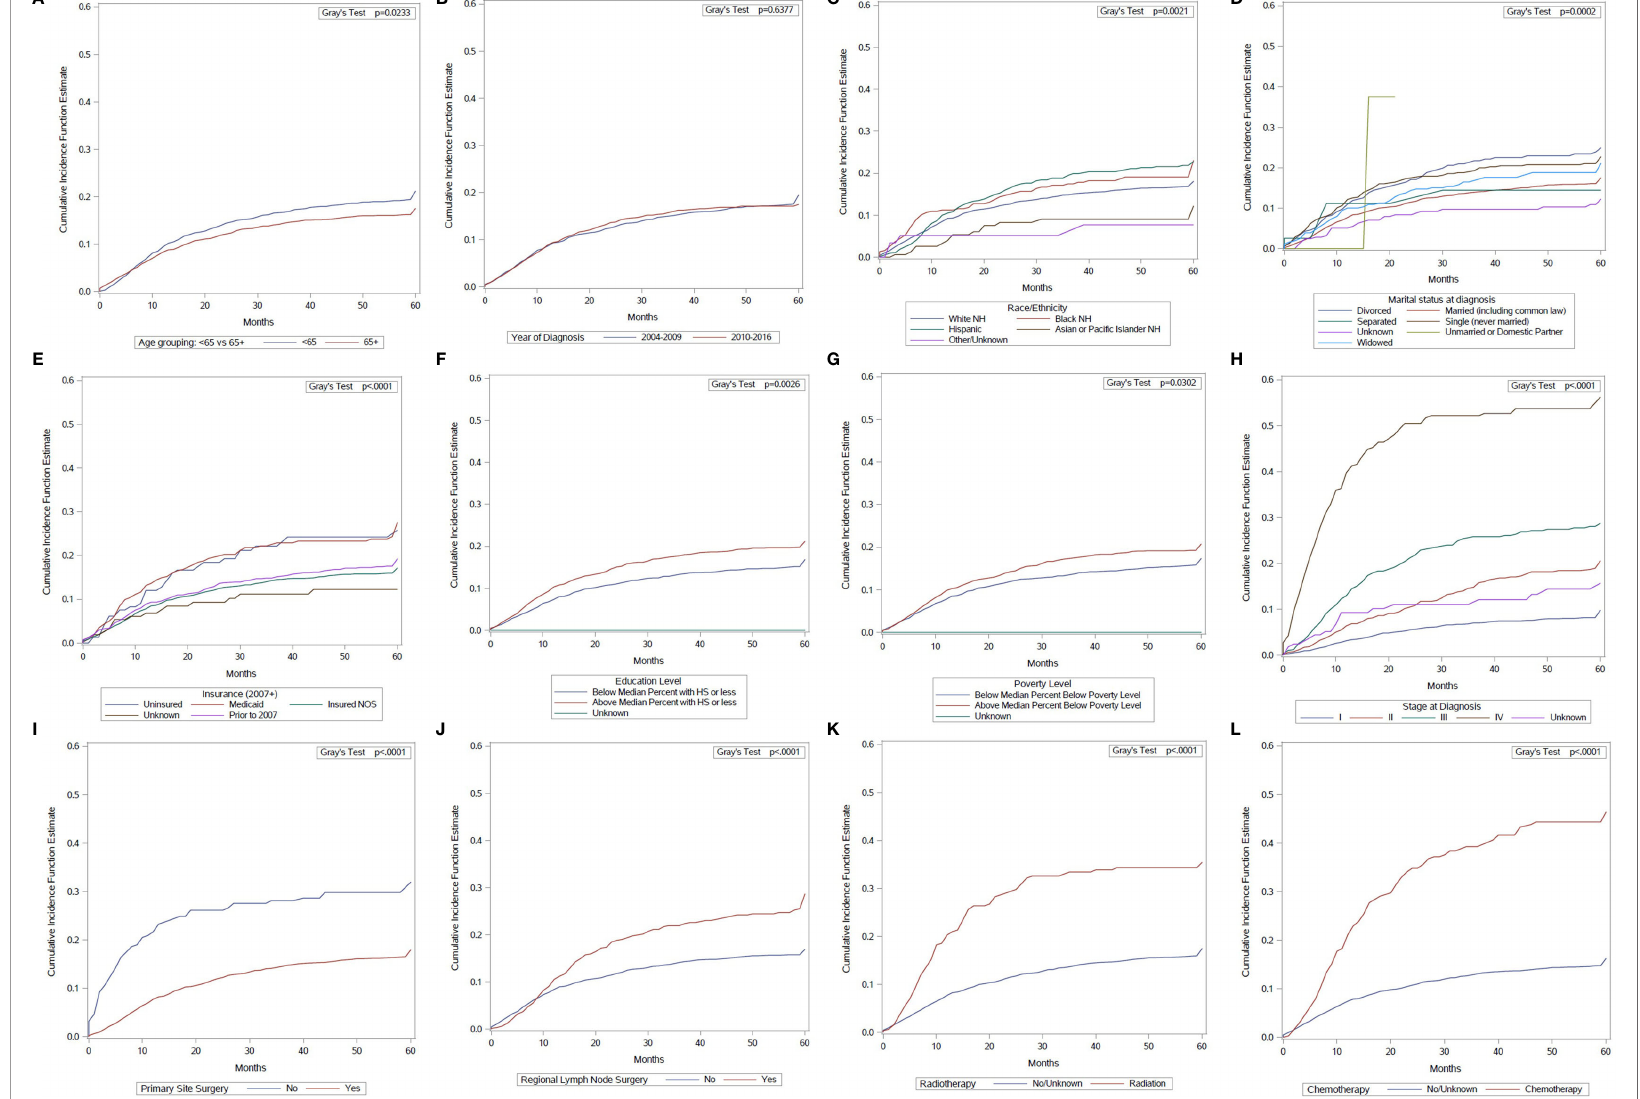
FIGURE 2 | Cumulative incidence function curves of penile cancer mortality according to: (A) age at diagnosis; (B) year of diagnosis; (C) race/ethnicity; (D) marital status; (E) insurance status; (F) education level; (G) poverty level; (H) stage at diagnosis; (I) primary site surgery; (J) regional surgery; (K) radiotherapy use; (L) chemotherapy